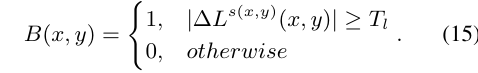
Algorithm 1: The proposed image denoising quality assessment